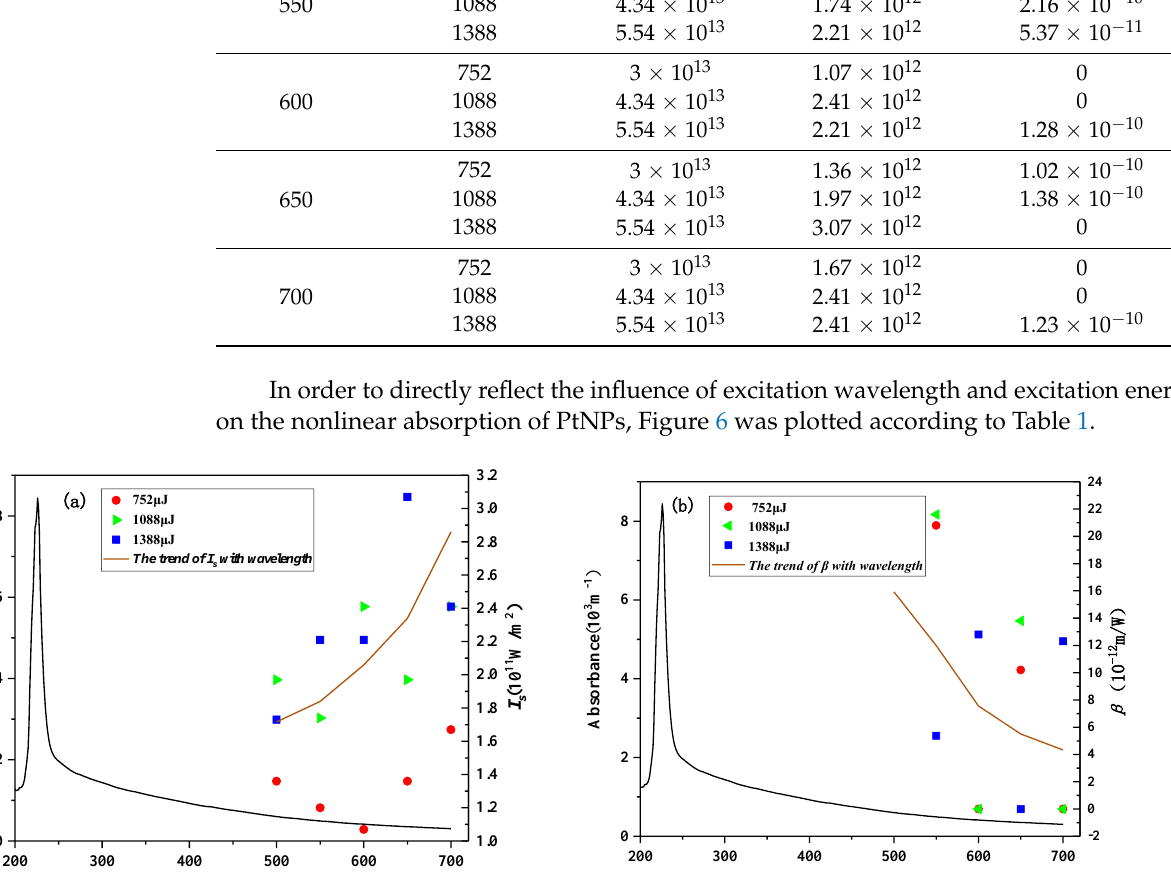
Table 1. Nonlinear Optical Parameters of PtNPs.